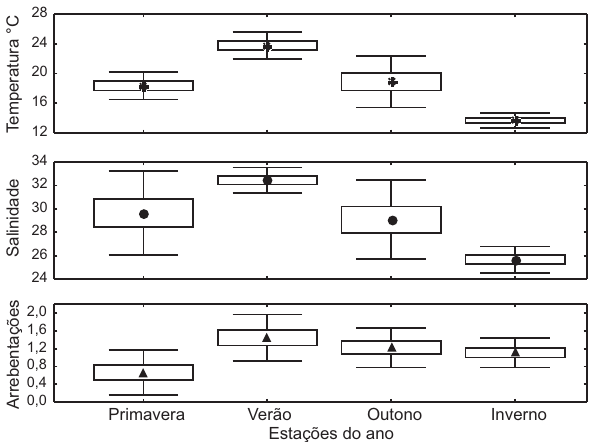
Figura 2. Variabilidade sazonal da temperatura, salinidade e número de linhas de